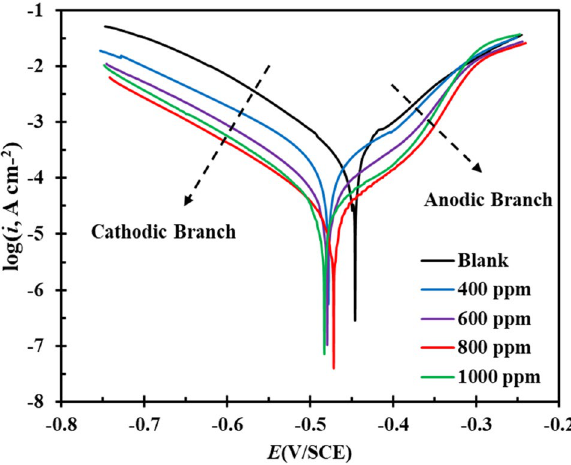
Figure 5. Polarization curves of MS submerged in blank and inhibitor-containing solutions.